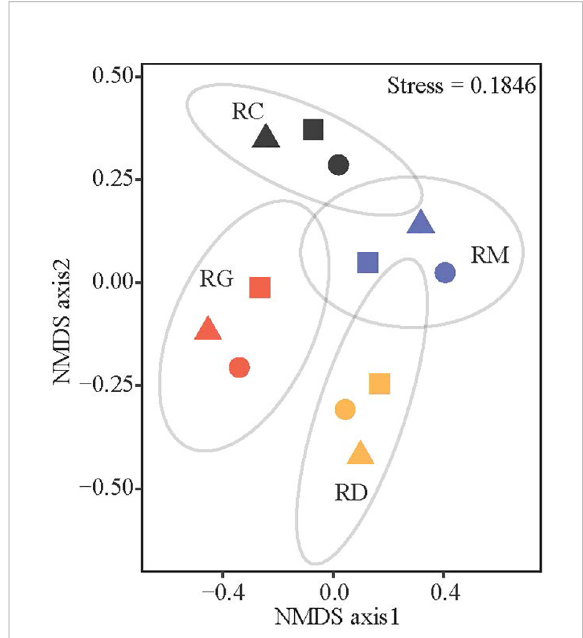
FIGURE 2 Nonmetric multidimensional scaling (NMDS) ordinations of weed communities based on their important value ( IV ) composition in the soil seed bank derived from Bray-Curtis distances matrices. In the fi gure, triangles, circles and squares represent weed communities in the fi elds in the north, middle and south of Jiangsu Province, respectively. Symbols with the color of red, blue, orange and black represent weed communities in the fi elds of rice-green manure rotation (RG), rice monoculture (RM), rice- duck co-culture (RD) and rice-cray fi sh co-culture (RC), respectively. Ellipses represent 95% con fi dence